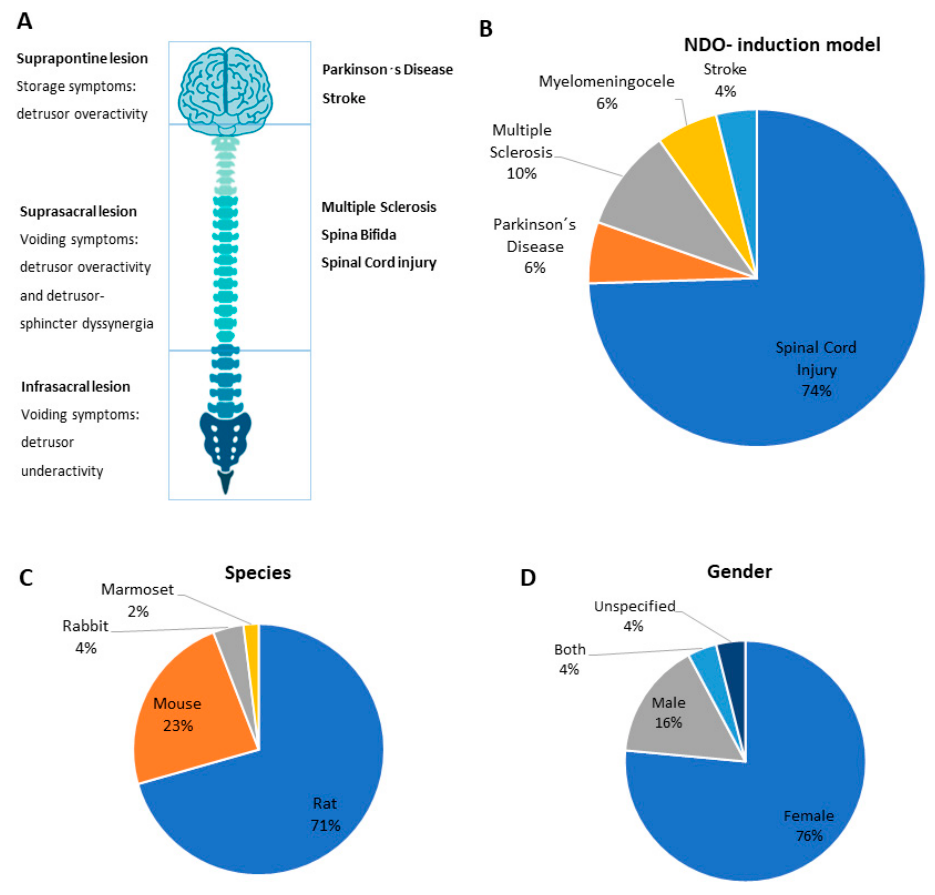
Figure 2. NDO-driven pathologies and animal models to induce them. ( A ) The consequences of central nervous system (CNS) injuries for urinary function are influenced by the level on which they occur: supraspontine lesions are associated with storage symptoms, suprasacral lesions are characterized by voiding symptoms, namely detrusor overactivity and detrusor sphincter dyssynergia, and infrasacral lesions are often associated with detrusor underactivity. ( B ) Animal models to induce neurogenic detrusor overactivity (NDO) are based on supraspontine or suprasacral lesions and include animal models of spinal cord injury (SCI), Parkinson’s disease (PD), multiple sclerosis (MS), myelomeningocele, and stroke. ( C ) The species used to induce NDO models are predominantly rats and mice, with little use of other small mammals, such as rabbits and marmosets. ( D ) Female animals were predominantly used.